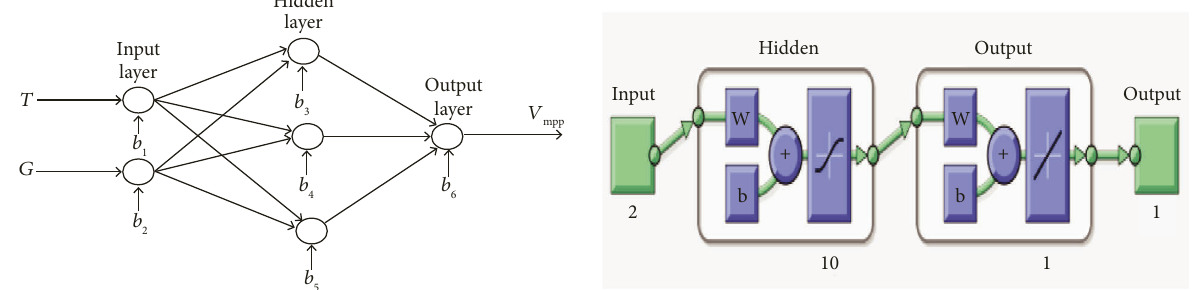
Figure 4: P&O algorithm flow